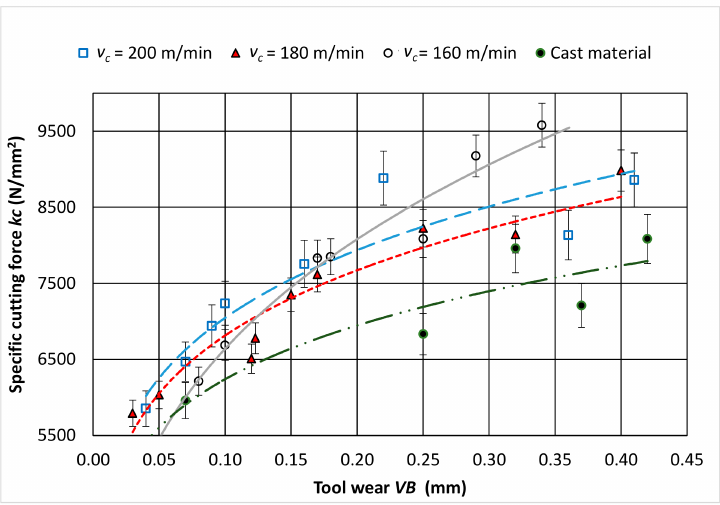
Figure 14. Relationship between the specific cutting force k c as a function of wear of the cutting tool VB.